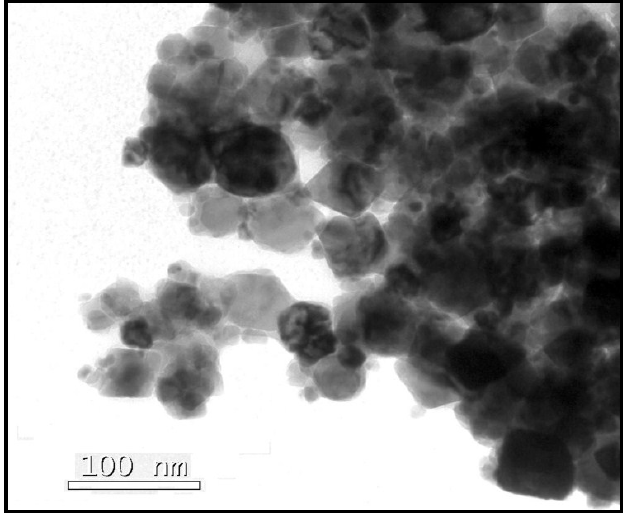
Figure 5. TEM micrograph of synthesized magnetite